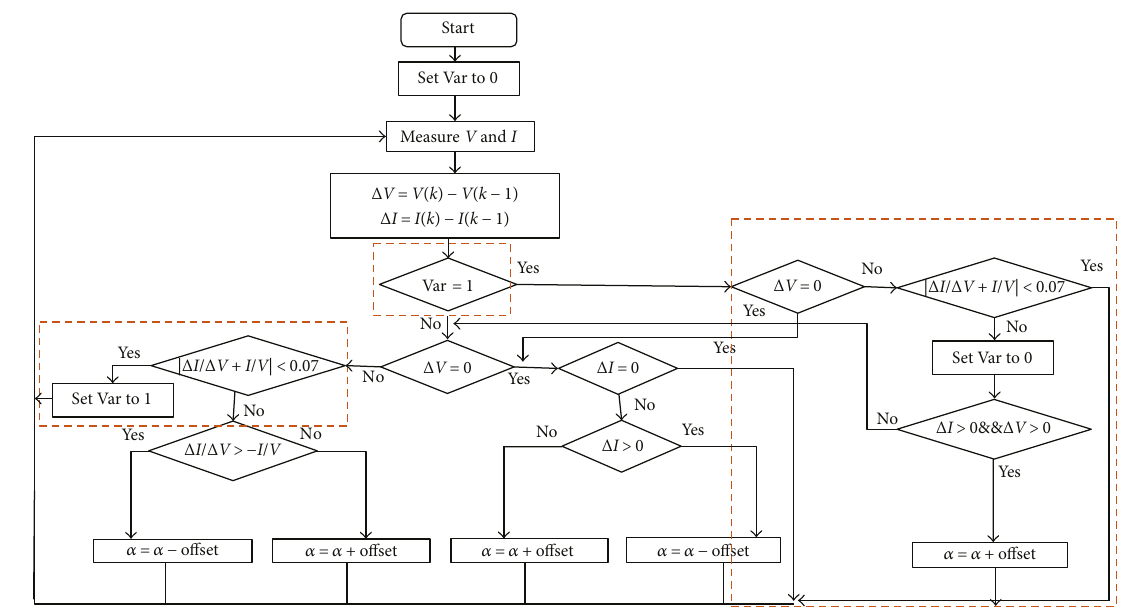
Figure 21: Flowchart of the proposed INC algorithm.